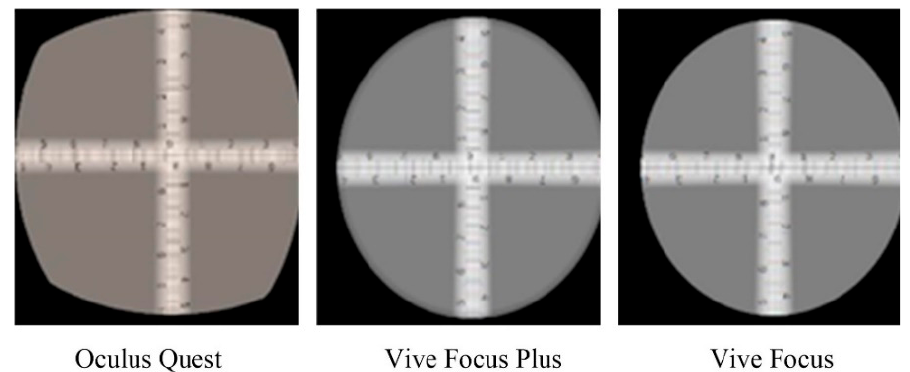
Figure 5. Rendering HFOV of different VR HMDs.